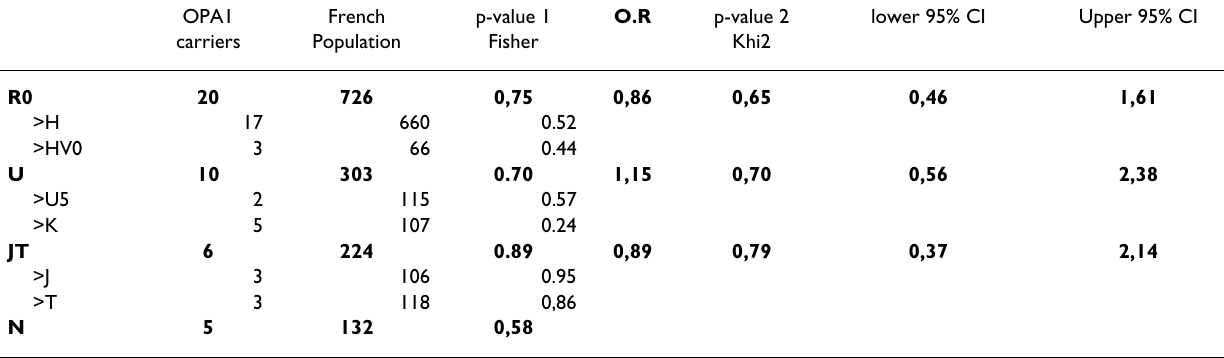
Table 2: Relative risk estimated of each haplogroup to develop the OPA1 pathology against the rest of the population OPA1 French p-value 1 O.R p-value 2 lower 95% CI Upper 95% CI